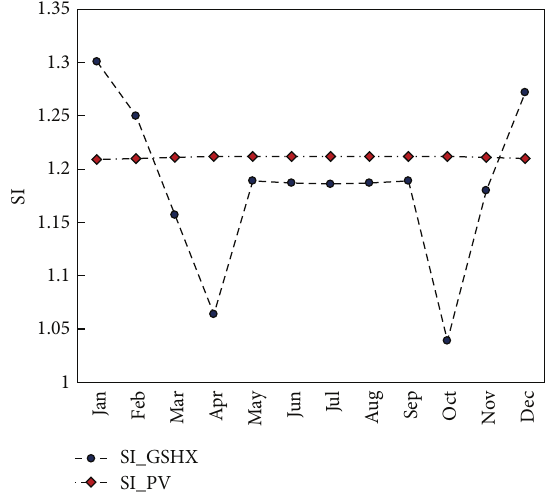
Figure 10: Relative irreversibility of GSHP components.